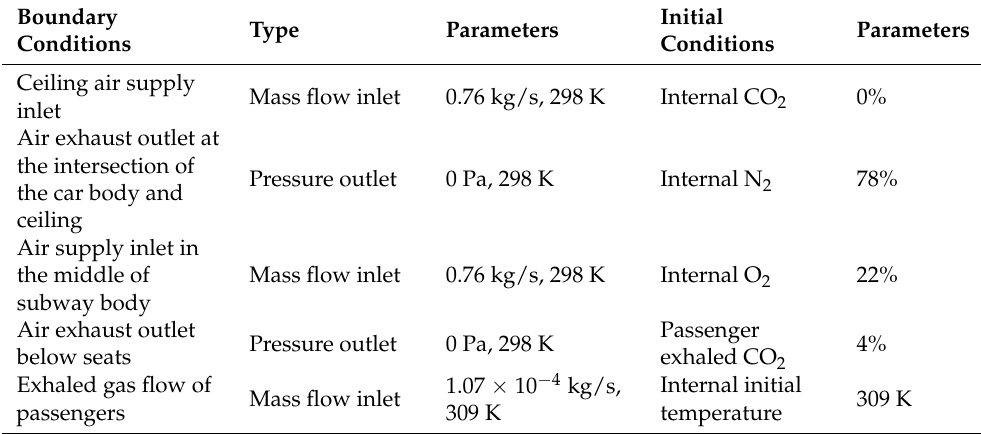
Table 1. Boundary and initial conditions for CFD